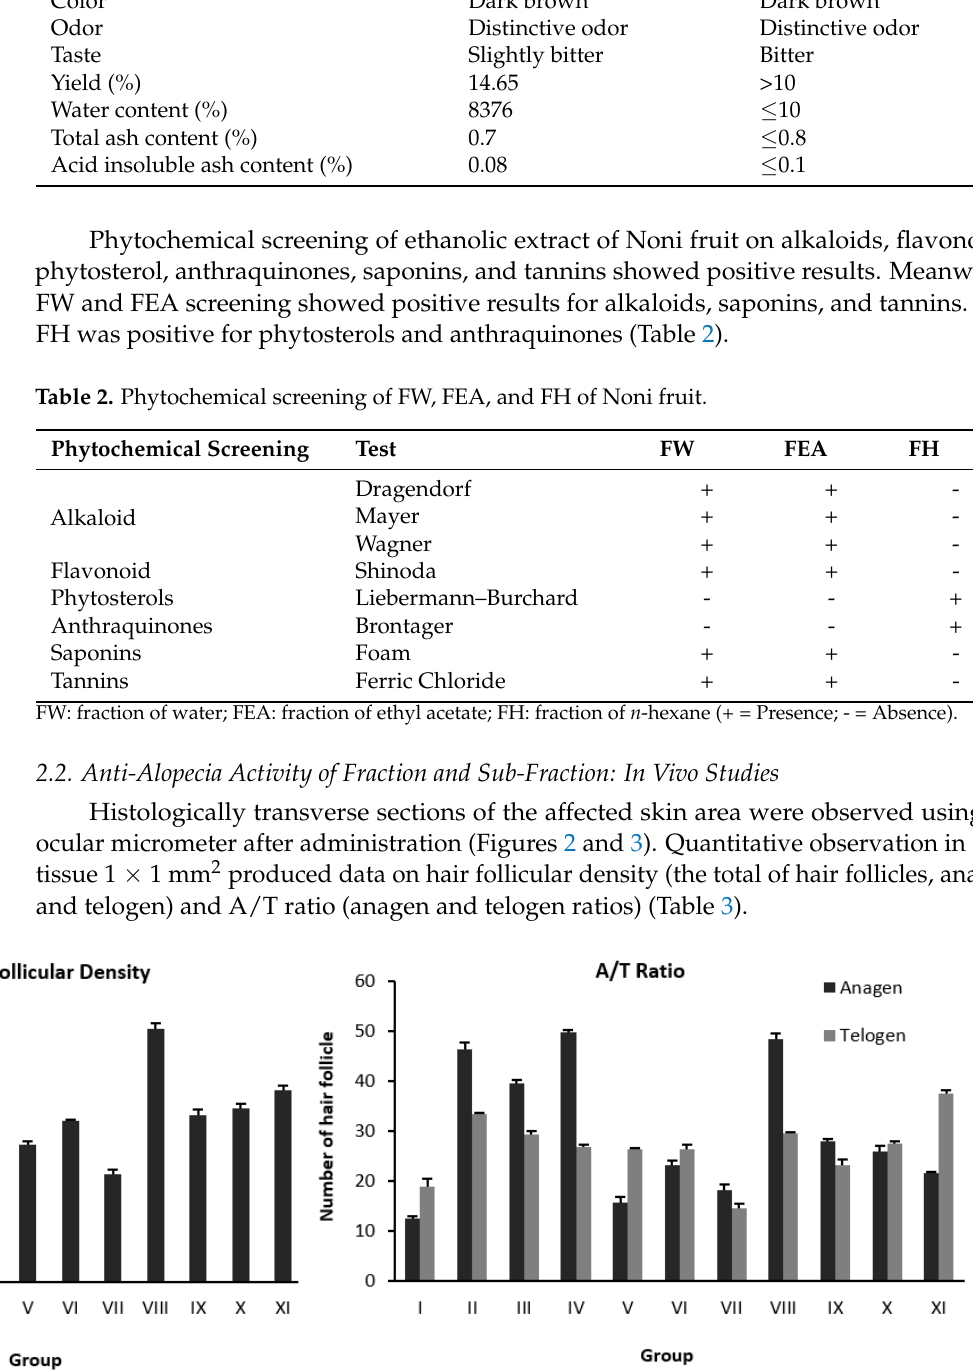
Figure 3. Photomicrograph comparison of hair follicles for each group; ( I ) DHT+vehicle, ( II ) DHT+Minoxidil, ( III ) DHT+FW 25%, ( IV ) DHT+FEA 25%, ( V ) DHT+FH 25%, ( VI ) DHT+FEA-1 25%, ( VII ) DHT+FEA-2 25%, ( VIII ) DHT+FEA-3 25%, ( IX ) DHT+FEA-4 25%, ( X ) DHT+FEA-5 25%, ( XI ) DHT+FEA-6 25% (magnification 20×).